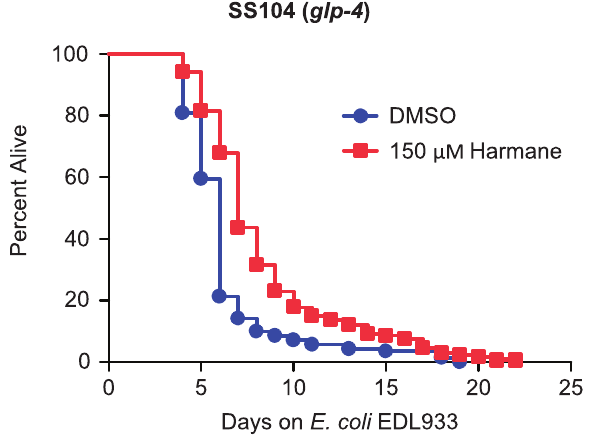
Figure 5. The effect of Harmane in glp-4 nematodes. E. coli EDL933 infection assay with glp-4 nematodes, exposed to DMSO or Harmane. The lifespan extension was from 6 days on DMSO to 7 days on Harmane [ P , 0.0001; DMSO, n=141; 150 m M Harmane, n=173].